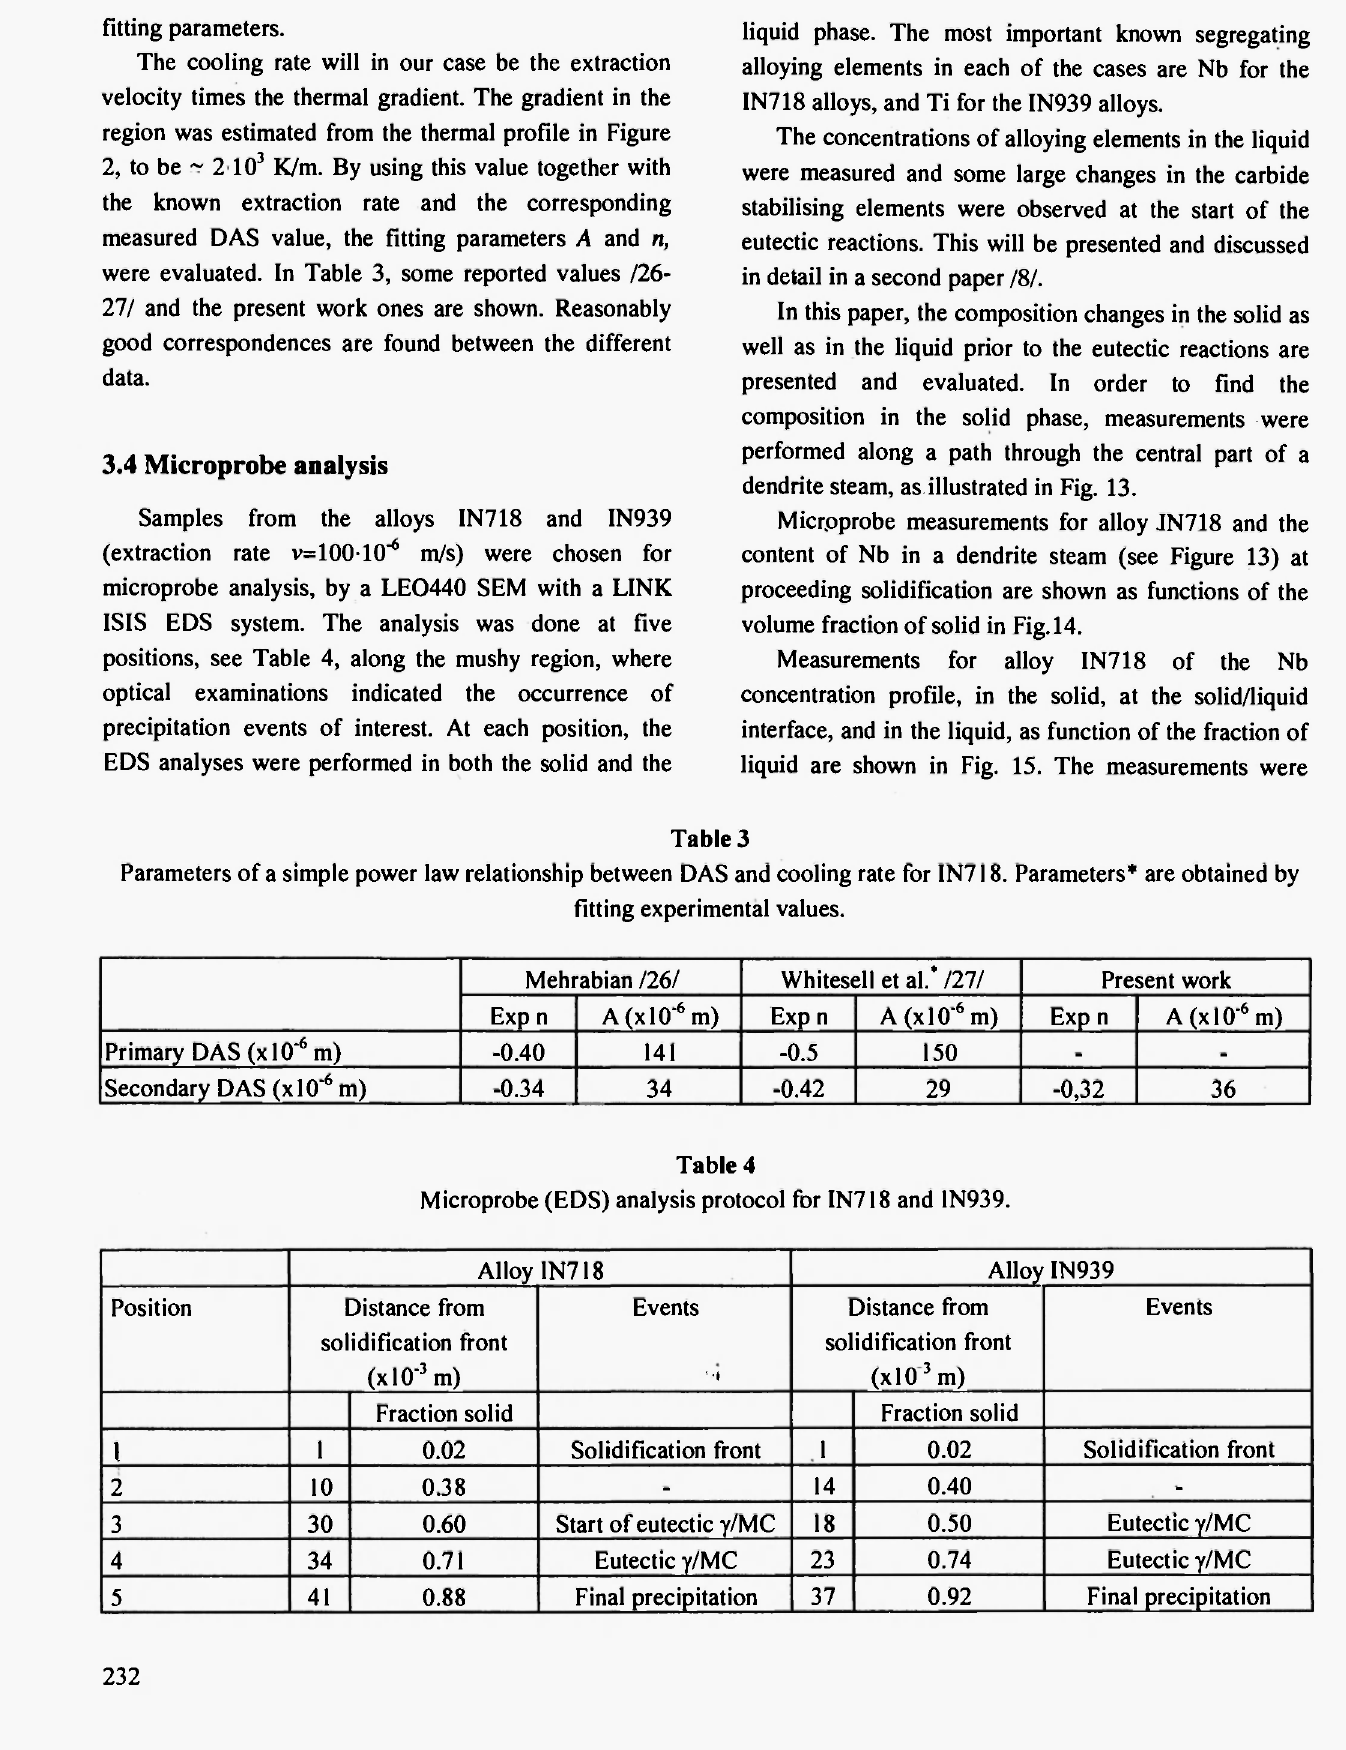
Parameters of a simple power law relationship between DAS and cooling rate for IN7I8. Parameters* are obtained by